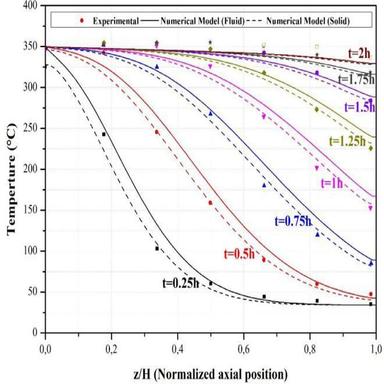
3. Experimentally and numerically obtained solid and fluid temperature along the tank height for different charging times.